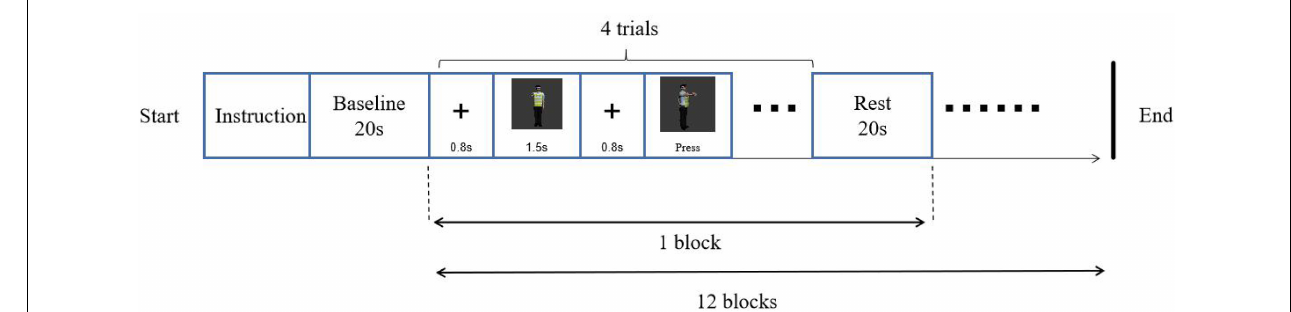
FIGURE 6 | Experimental procedure of subject mental